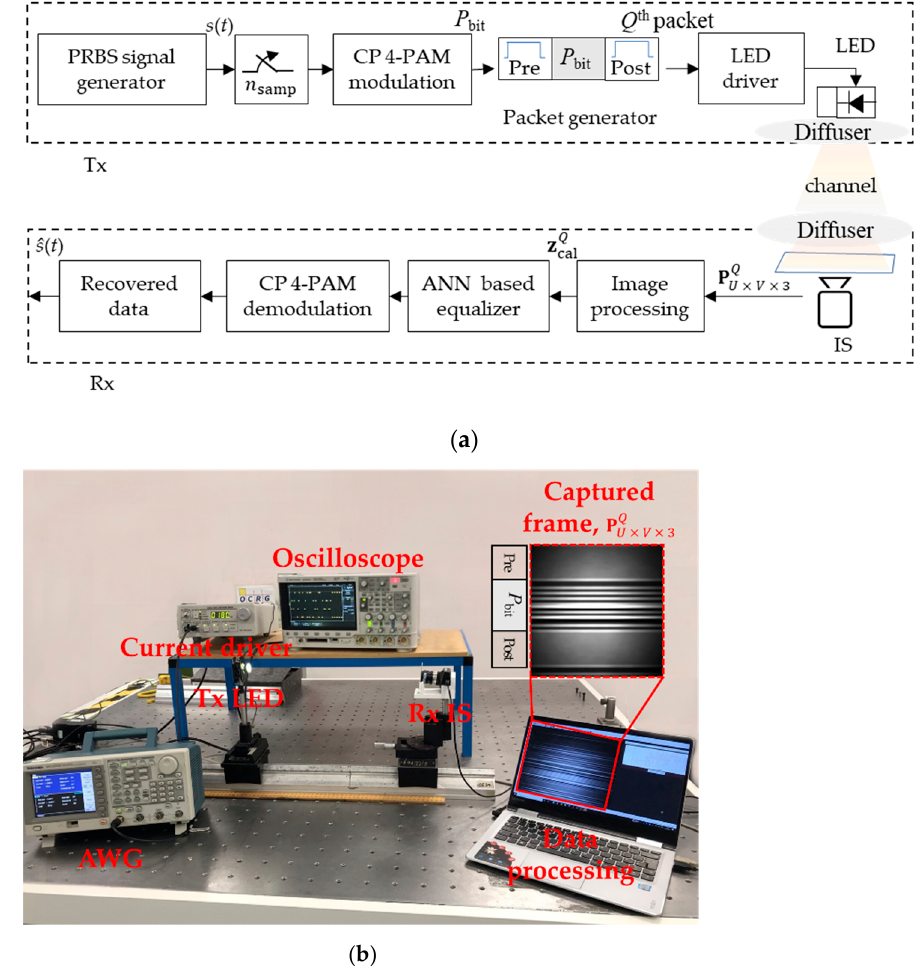
Figure 4. The CP 4-PAM OCC scheme: ( a ) System block diagram, and ( b ) photograph of the experimental setup.